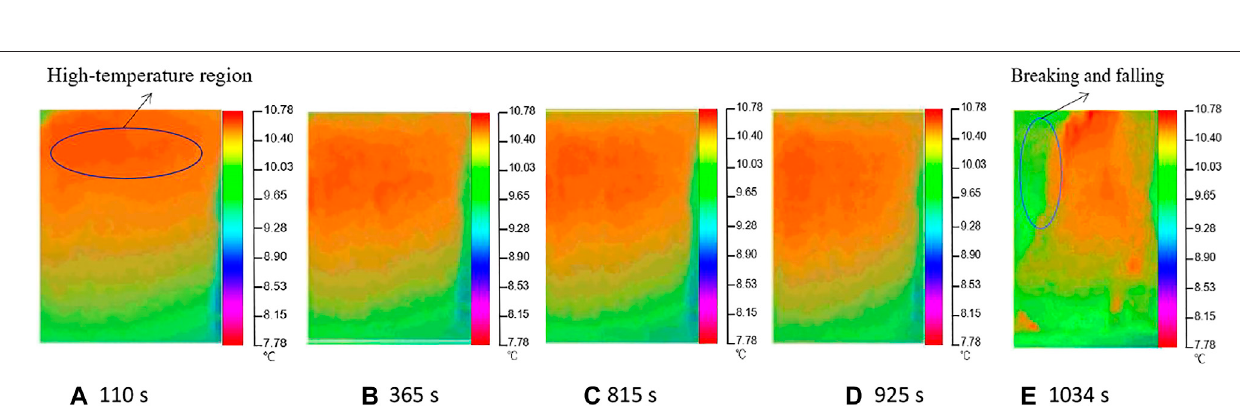
Frontiers in Earth Science |